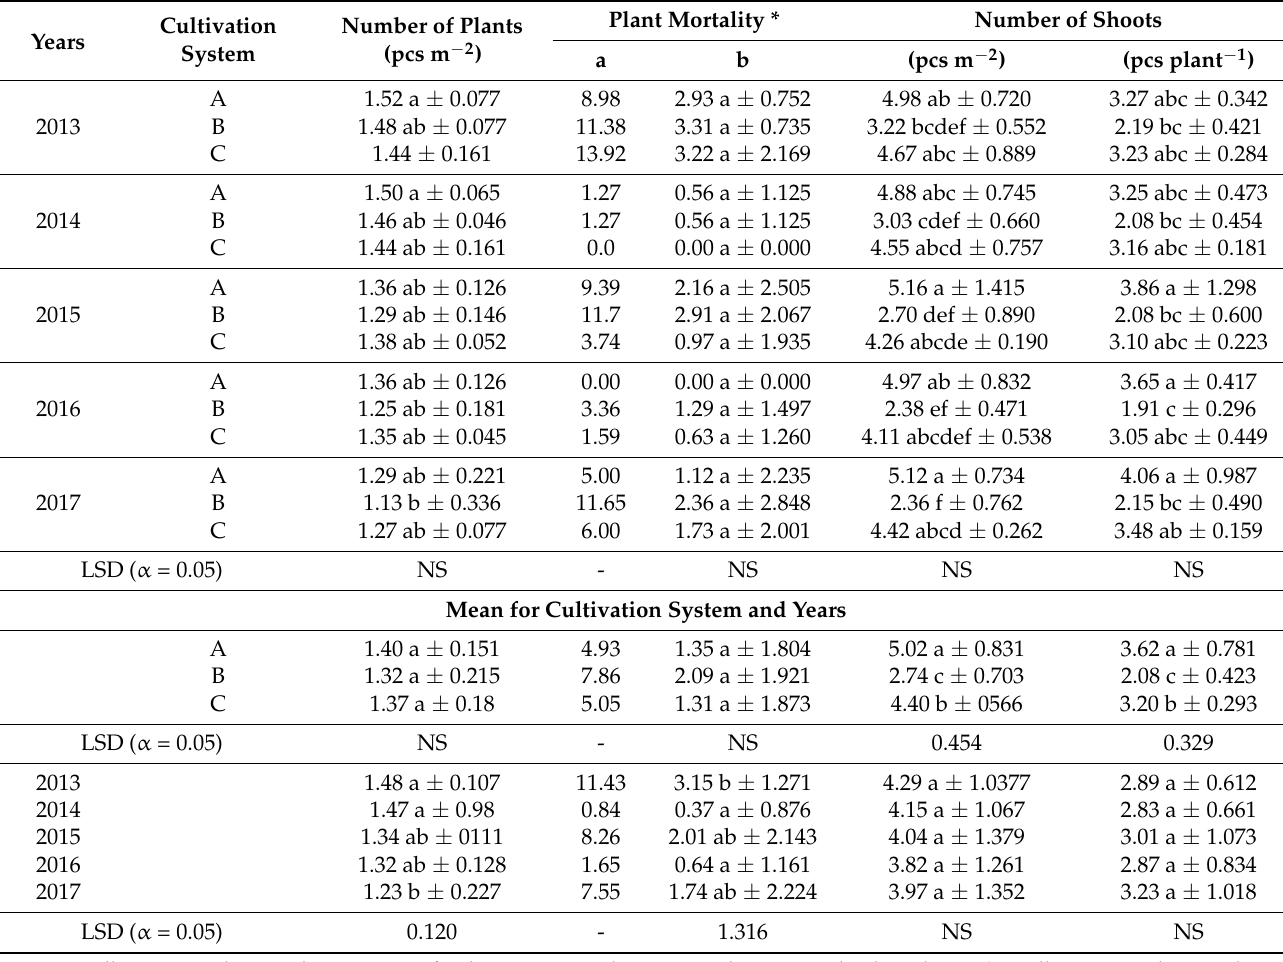
Table 5. Plant density in undersowing and monoculture